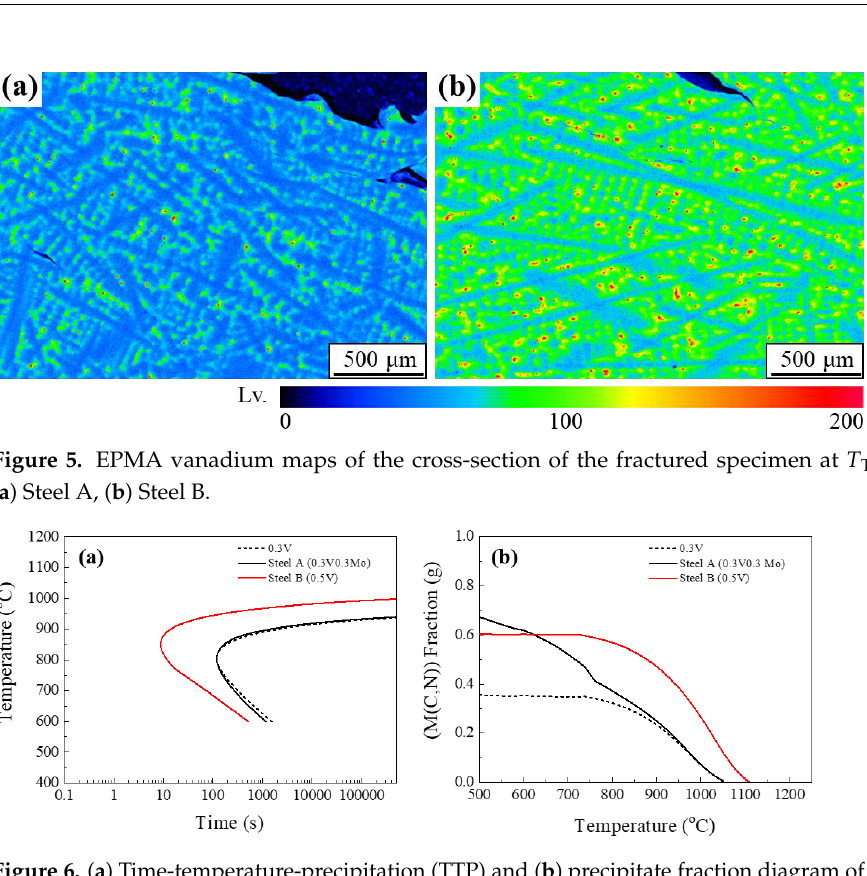
Figure 6. ( a ) Time-temperature-precipitation (TTP) and ( b ) precipitate fraction diagram of different V and Mo composition, as calculated using J-MatPro software.